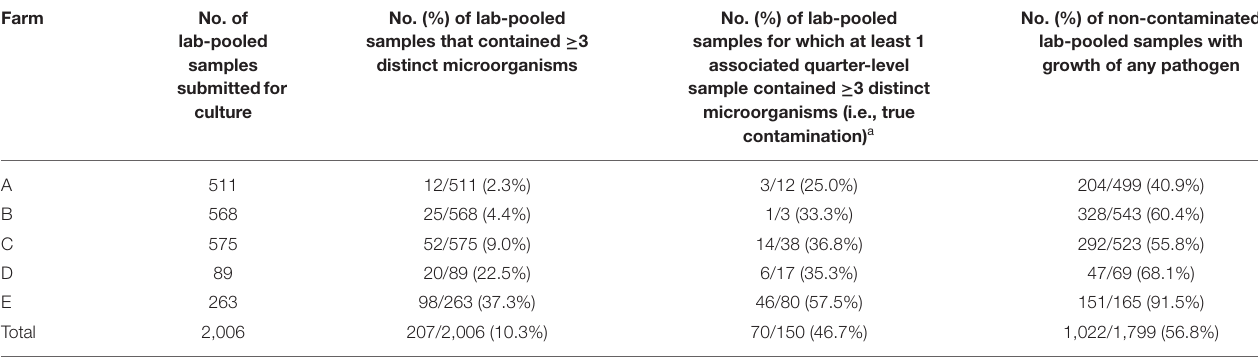
TABLE 4 | Counts and percentages of lab-pooled samples with contamination, true contamination, and growth of at least one mastitis pathogen within each farm. Farm